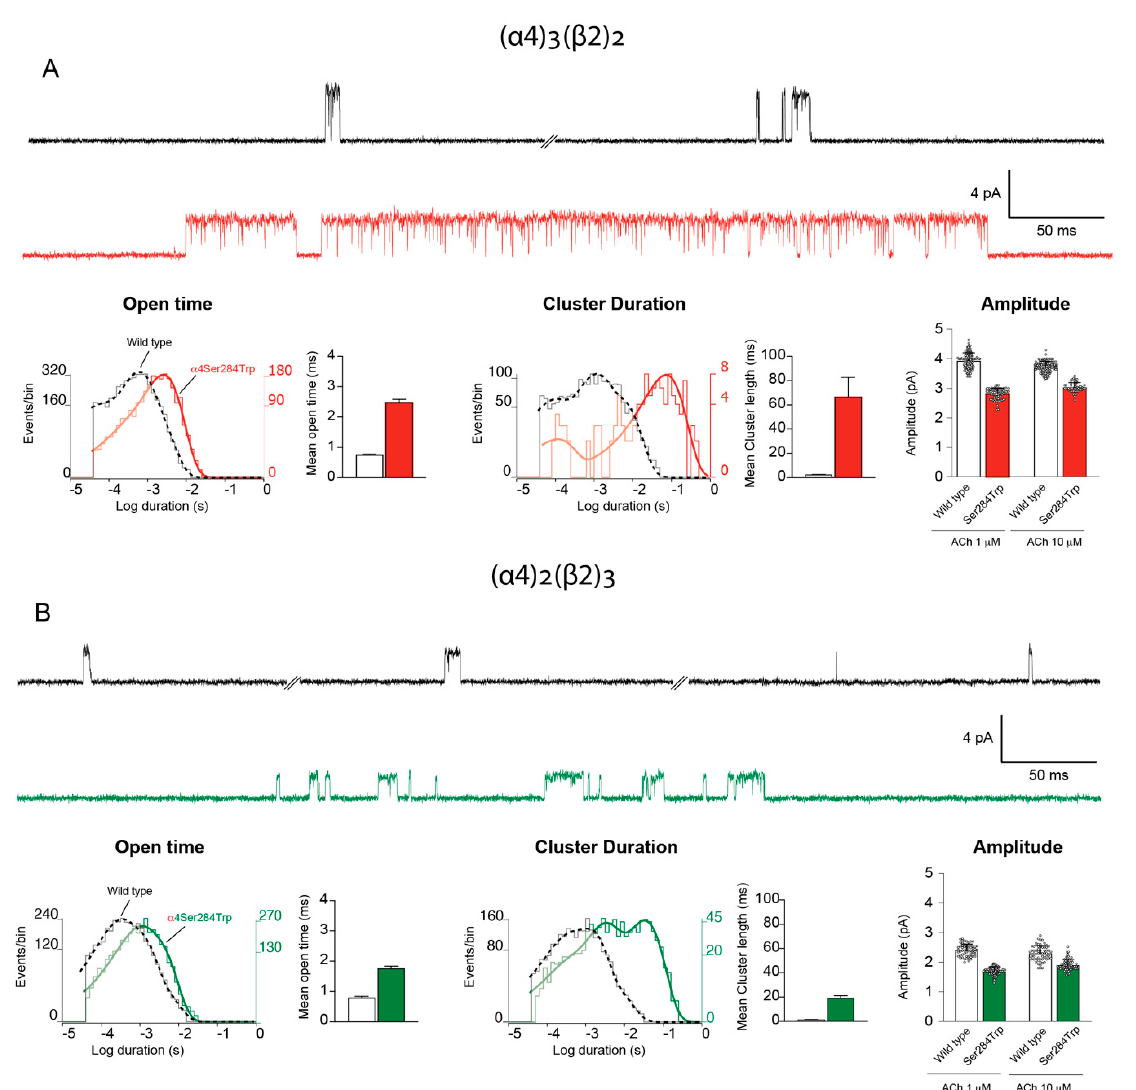
Figure 5. Single channel recordings from wild type and α 4Ser284Trp β 2 nAChRs activated by ACh. ( A ) Recording from a Bosc − 23 cell expressing the ( α 4)3( β 2)2 stoichiometry of wild type (black trace) or mutant (red trace) nAChRs in the presence of 10 µM ACh. Corresponding histograms of open and cluster durations, fitted by the sum of exponentials, are shown below. Unitary current amplitude for wild type and mutant nAChRs is compared for recordings in the presence of either 1 or 10 µM ACh. Each symbol represents the open channel current from a continuous data segment containing multiple channel openings. ( B ) Recording from a Bosc-23 cell expressing the ( α 4)2( β 2)3 stoichiometry of wild type (black trace) or α 4-Ser284Trp (green trace) nAChRs in the presence of 1 µM ACh. Corresponding histograms of open and cluster durations, fitted by the sum of exponentials, are shown below. Unitary current amplitude for wild type and α 4-Ser284Trp nAChRs is compared for recordings in the presence of either 1 or 10 µM ACh, as in panel A. The recordings in A and B were obtained in the cell-attached patch configuration at a membrane potential of − 70 mV. The bandwidth for display is 5 kHz.